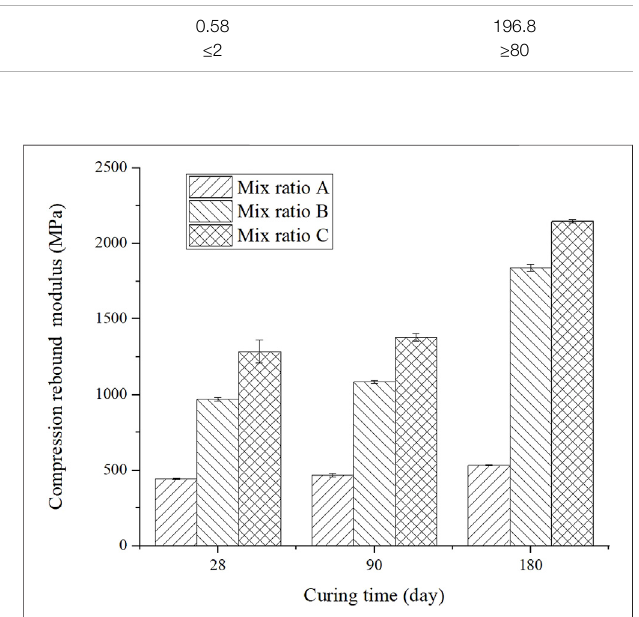
TABLE 4 | Mixing proportion of the PLF mixture.